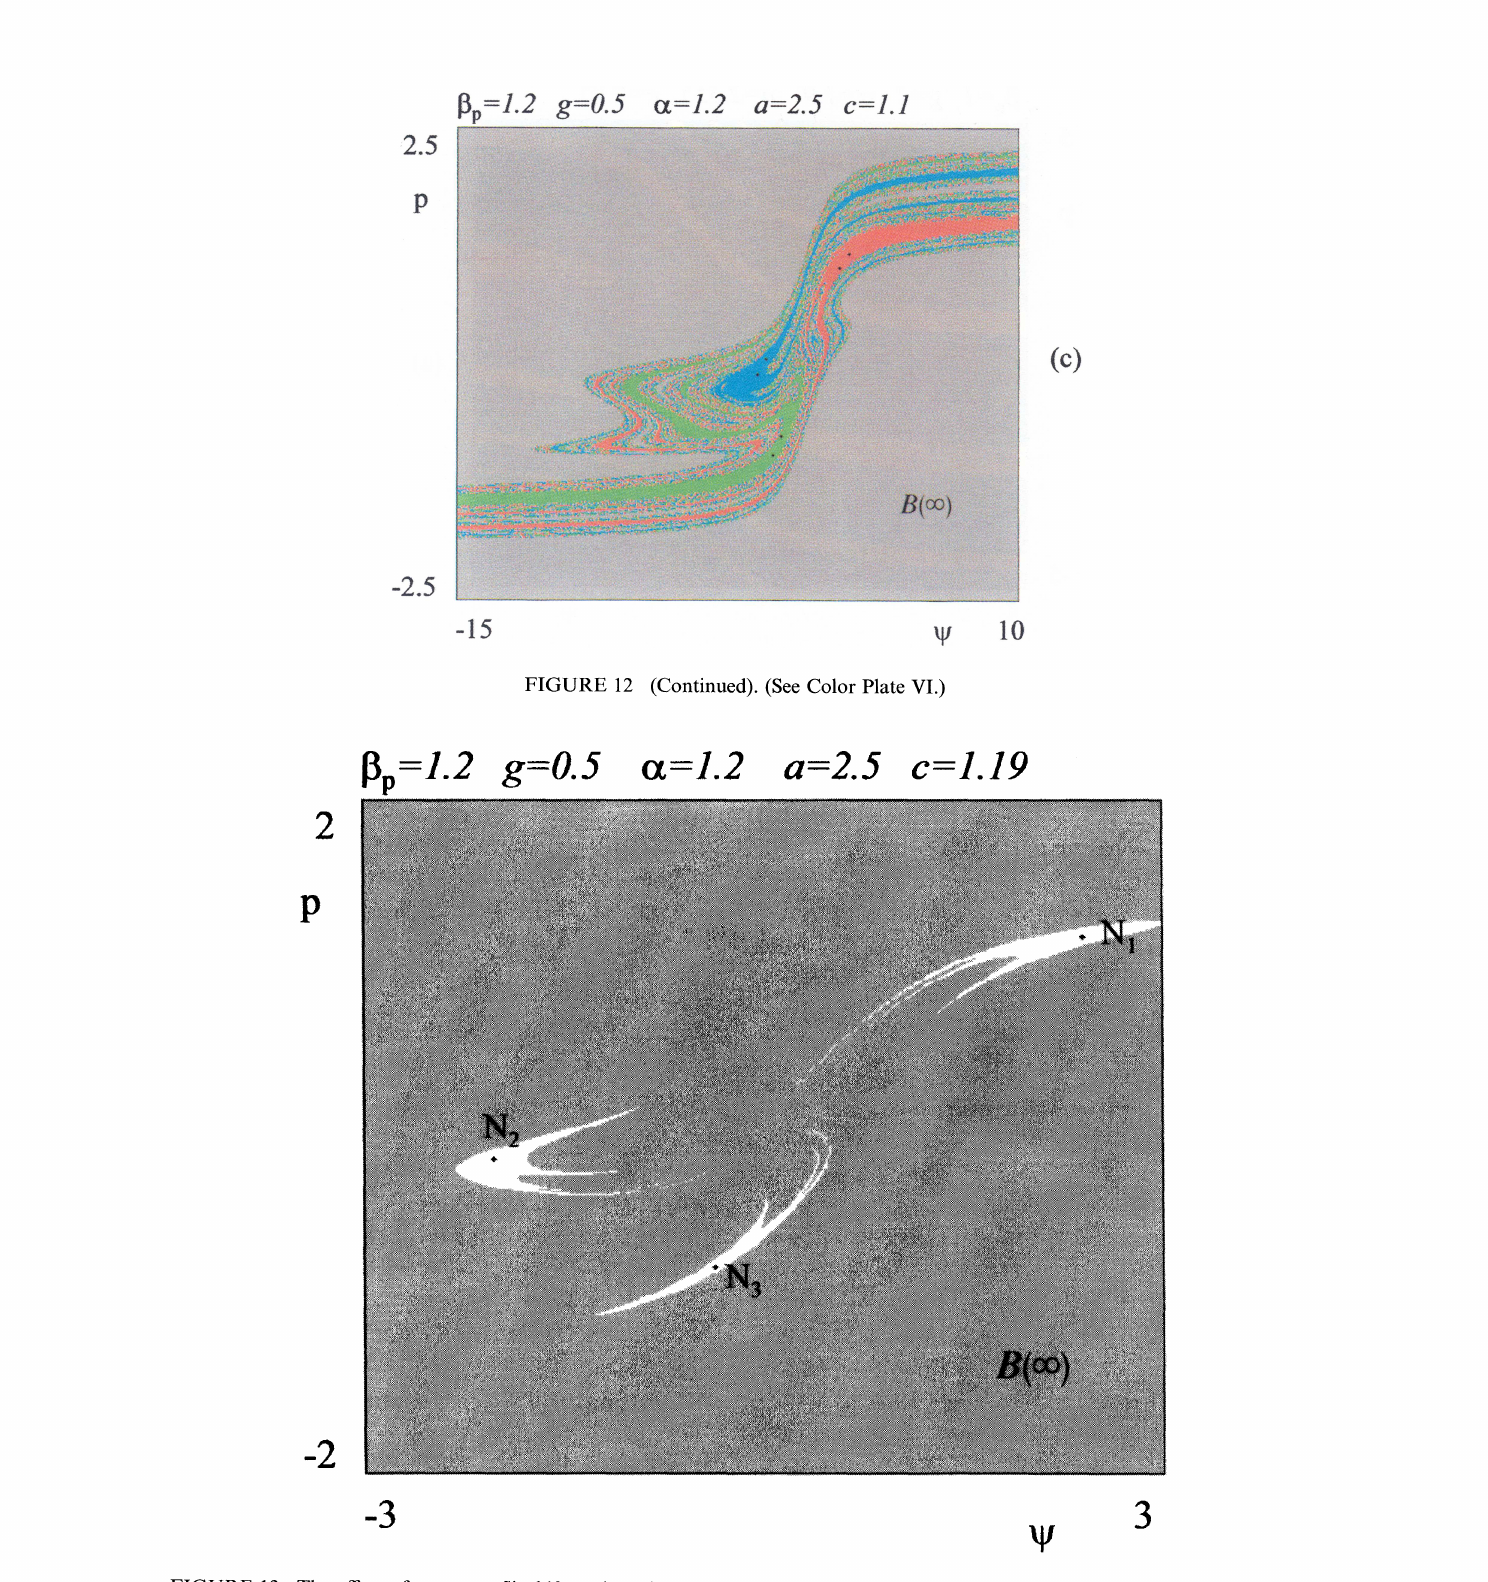
FIGURE 13 The effect of a reverse flip bifurcation observed by increasing c further with respect to the parameter situation of Figure 12. For/3p 1.2, g =0.5, c 1.2, a= 2.5 and c= 1.19, an attracting 3-cycle C3 is again the only attractor, as in Figure 9a, but its basin is now very small as compared